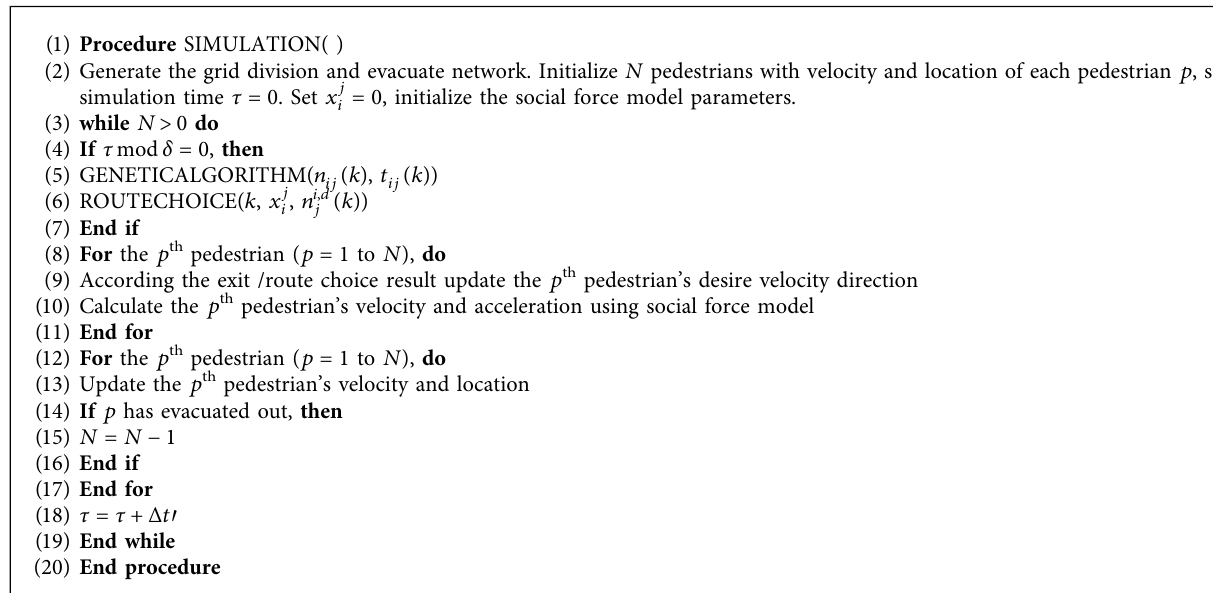
A LGORITHM 6 : Simulation algorithm for evacuation.